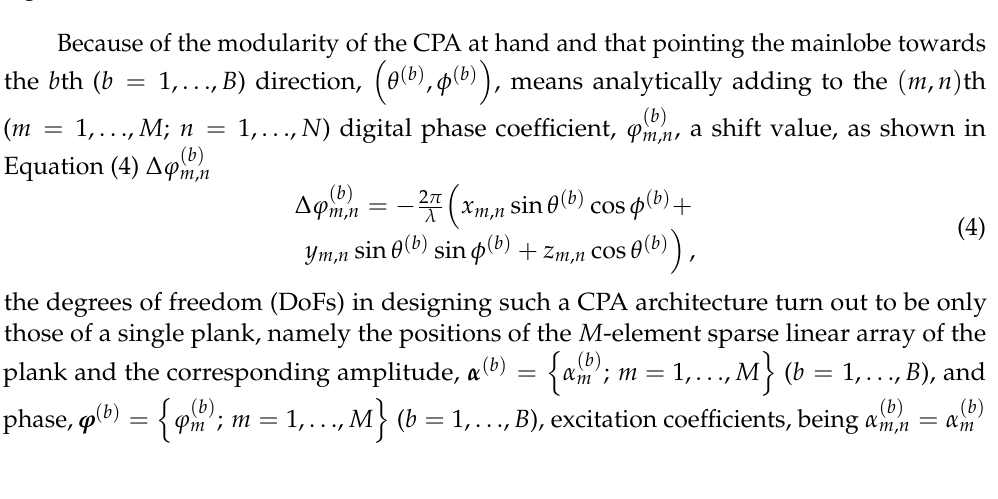
Figure 2. Sketch of the transversal section of the CPA and of the radiation